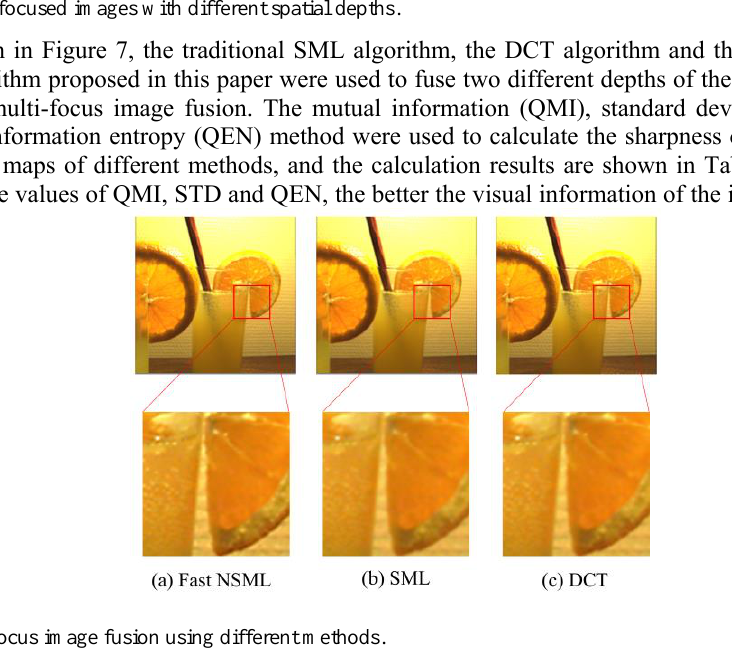
Fig. 7. Multi focus image fusion using different